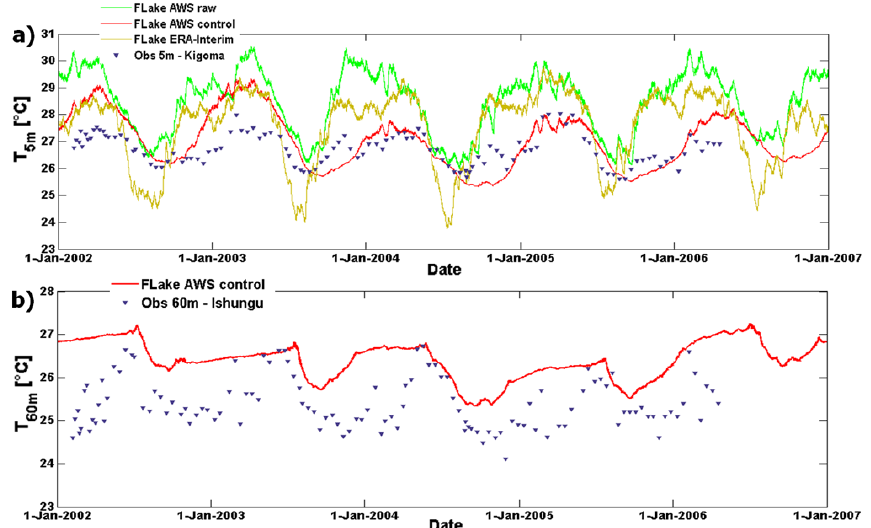
Fig. 6. Modelled and observed temperature evolution at Kigoma (northern basin of Lake Tanganyika) at (a) 5m, and (b) 60m depth. FLake temperatures at 60m predicted by the raw and ERA-Interim integration are omitted as they are constant at 3.98 ◦